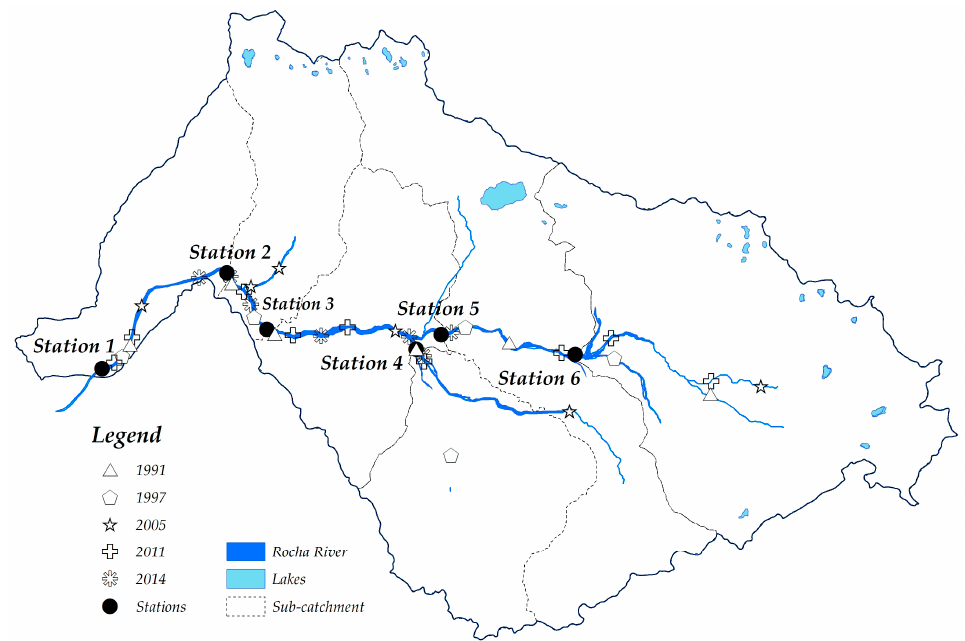
Figure 4. Map of the study area showing sub-catchments for each sampling station, water bodies, and location of water sampling sites in former studies (1991–2014) (non-filled symbols) and in the current study (2017) (filled circles).